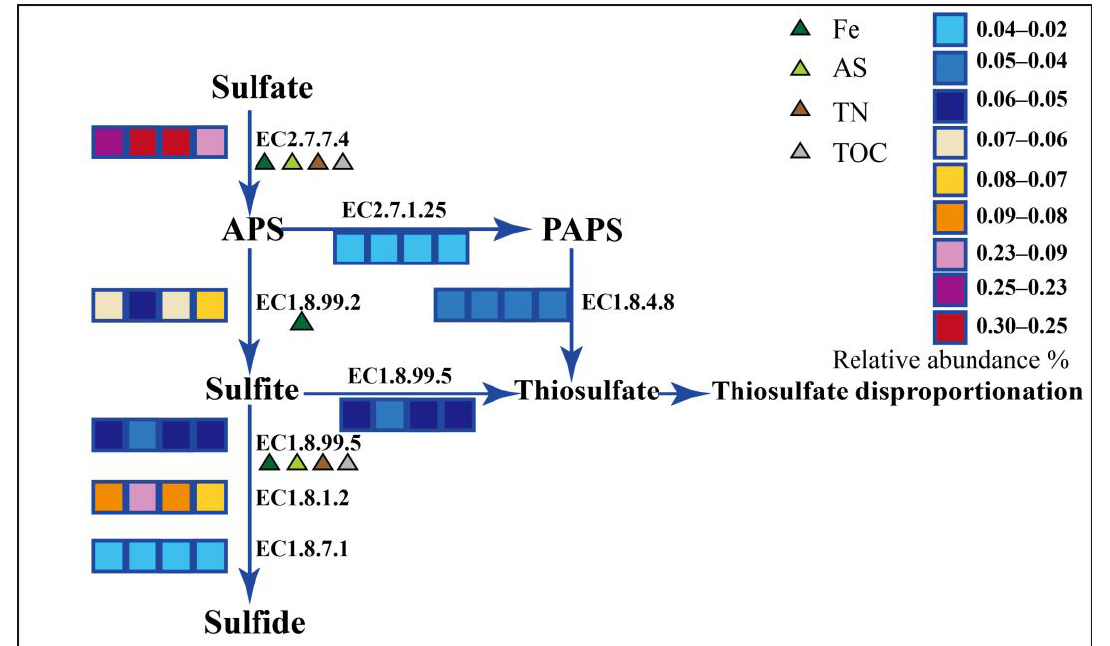
Figure 6. Model for the pathway of the dissimilatory sulfate reduction. Relative abundance values of gene-encoding enzymes involved in the dissimilatory sulfate reduction. The EC numbers of enzymes are boxed. The relative abundance values of enzymes in the samples are shown in the nearby color bar, in which the four segments from left to right represent MS, NMS, RS, and NRS. The effects of sediment properties on dissimilatory sulfate-reducing genes are depicted within the triangle.